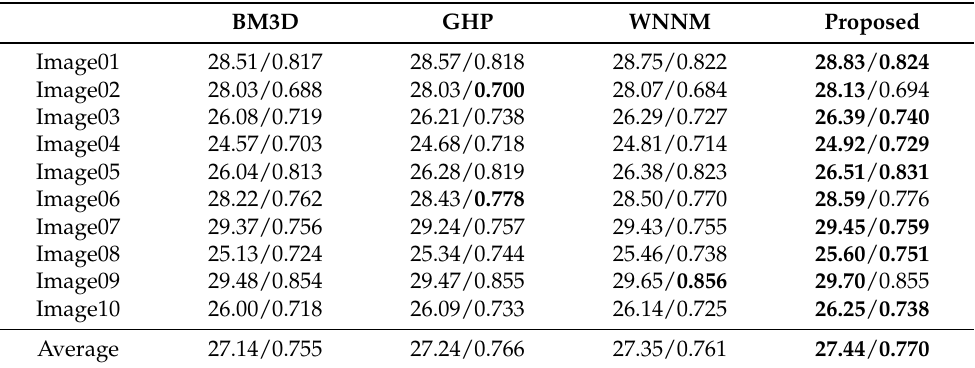
Table 3. The PSNR [dB] and SSIM results obtained after denoising on dataset I (with a noise standard deviation of 𝜎 = 30). BM3D WNNM Proposed